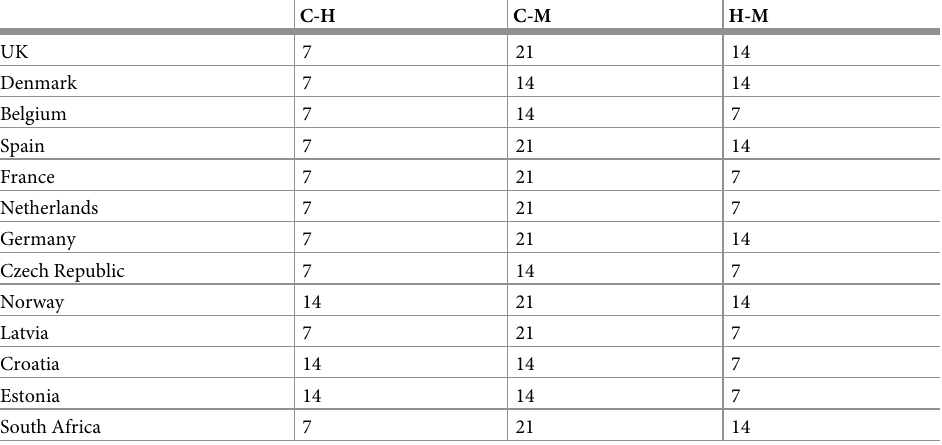
Table 1. The best fitting delay (lag) δ in days chosen via the AIC for both methods used in this study for the coun- try-by-country model. The abbreviations C-H , C-M and H-M refer to the cases to hospitalizations, cases to mortality and hospitalizations to mortality scenarios